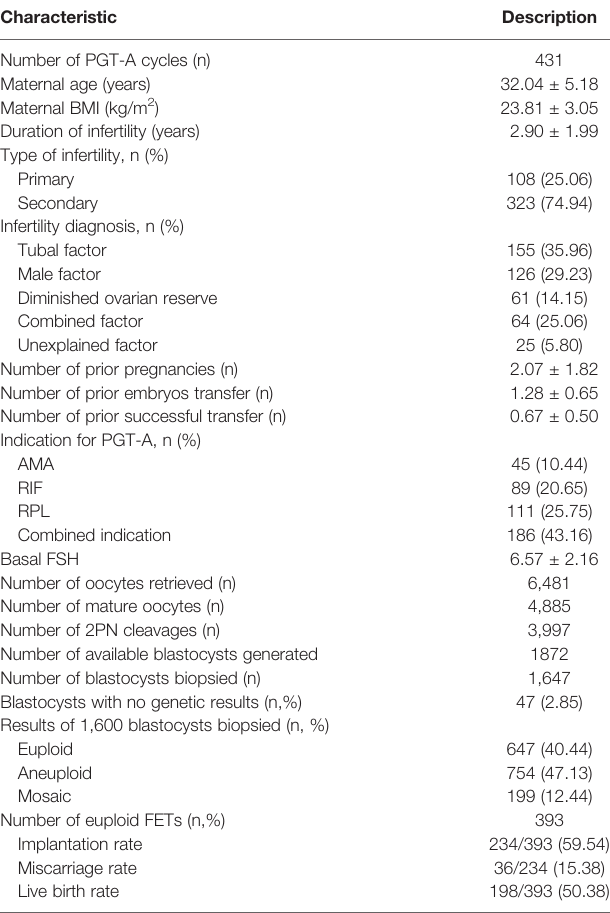
TABLE 1 | Embryological and clinical outcomes in patients who underwent PGT-A cycles.